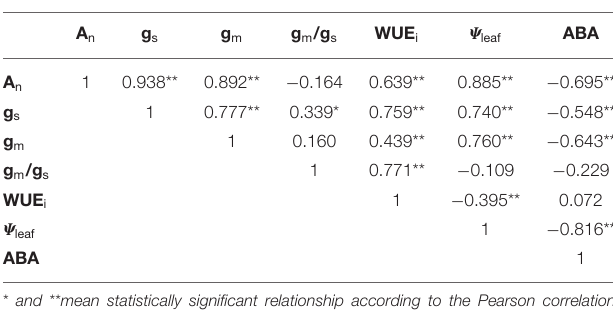
TABLE 1 | Correlation matrix between studied parameters including intrinsic water use efficiency (WUE i ), net photosynthesis (A n ), mesophyll conductance (g m ), stomatal conductance (g s ) and the ratio (g m /g s ), abscisic acid (ABA), and leaf water potential ( Ψ leaf ).